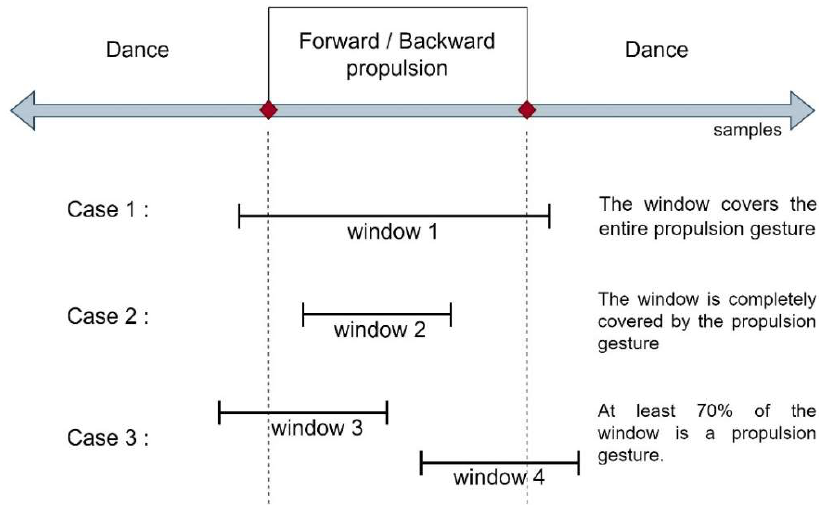
Figure 13. Conditions in the labeling of each window.